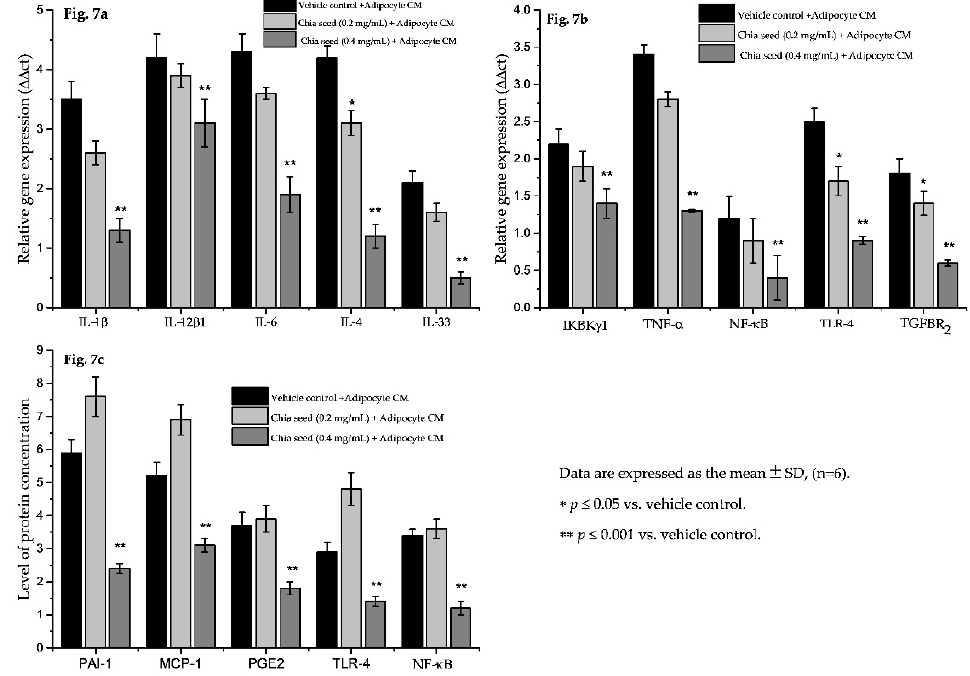
Figure 7. Changes in macrophage inflammatory marker related mRNA expression ( a , b ) and protein levels ( c ) of chia seed-treated adipocyte condition media-treated macrophage after 12 h.